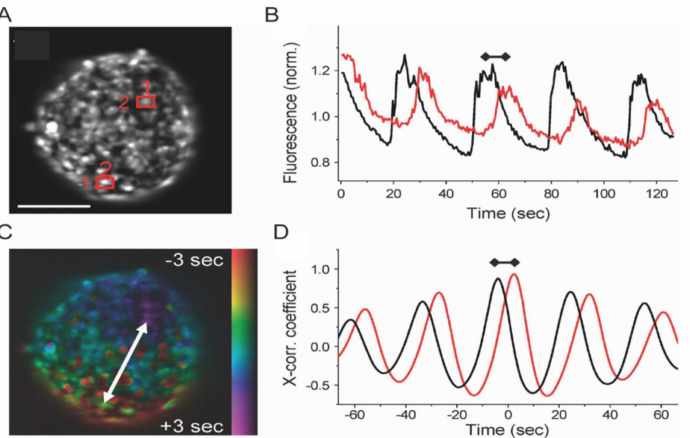
Figure 6. Ca 2+ imaging with fluorescent biosensor. ( A ) Intensity image of Fluo-4-stained islet. Scale bar: 100 µ m. ( B ) Time course of Fluo-4 intensity oscillations in the two cells highlighted in (A) (red rectangle). Oscillations of cell 1 (black line) precede those of cell 2 (red line). ( C ) False color scale phase map representing the propagation of the calcium wave across the islet from regions colored in red (early [Ca 2+ ] increase) to regions colored in blue/purple (later [Ca 2+ ] increase). ( D ) Cross correlation trace of cell 1 and 2. Difference in time between peaks represents the propagation of Ca 2+ waves. Adapted from Benninger et al.